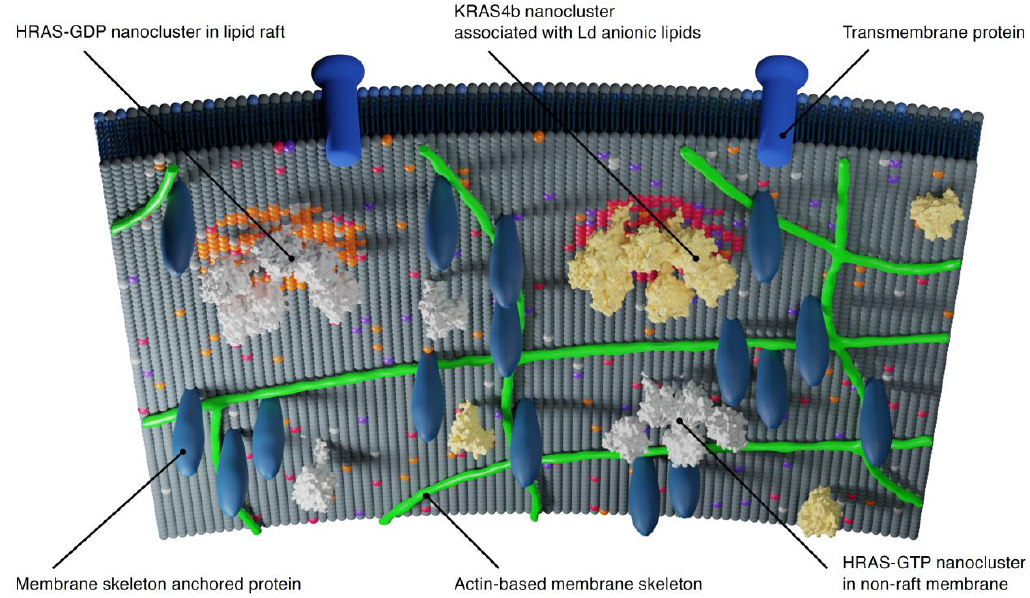
Figure 3. Hierarchical membrane compartments define RAS nanocluster organization. Membrane compartments (40–300 nm in diameter) are formed by actin-based cytoskeleton and transmembrane proteins that are attached to the cytoskeleton. Within these compartments, lipid domains form and are defined by lipid–lipid and lipid–protein interactions. For example, HRAS-GDP nanoclusters assemble in lipid rafts, whereas HRAS-GTP cluster in non-raft membrane, and KRAS4b interact with liquid disordered anionic lipids. This figure was inspired by the work described in [14].